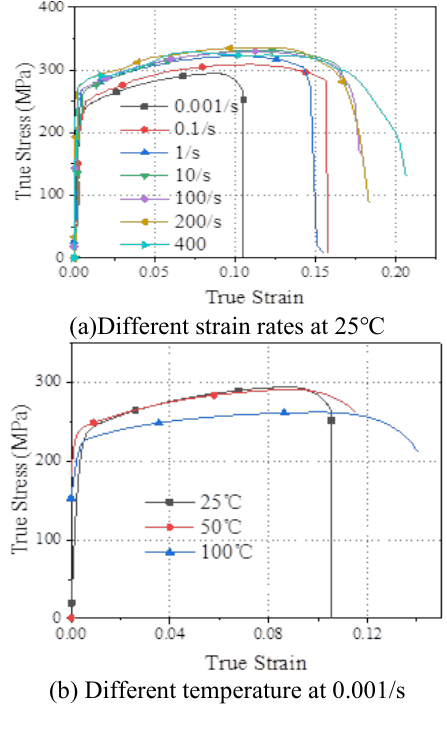
The real stress-strain curves of 6082-T6 at different strain rates and temperature parameters are shown in Figure